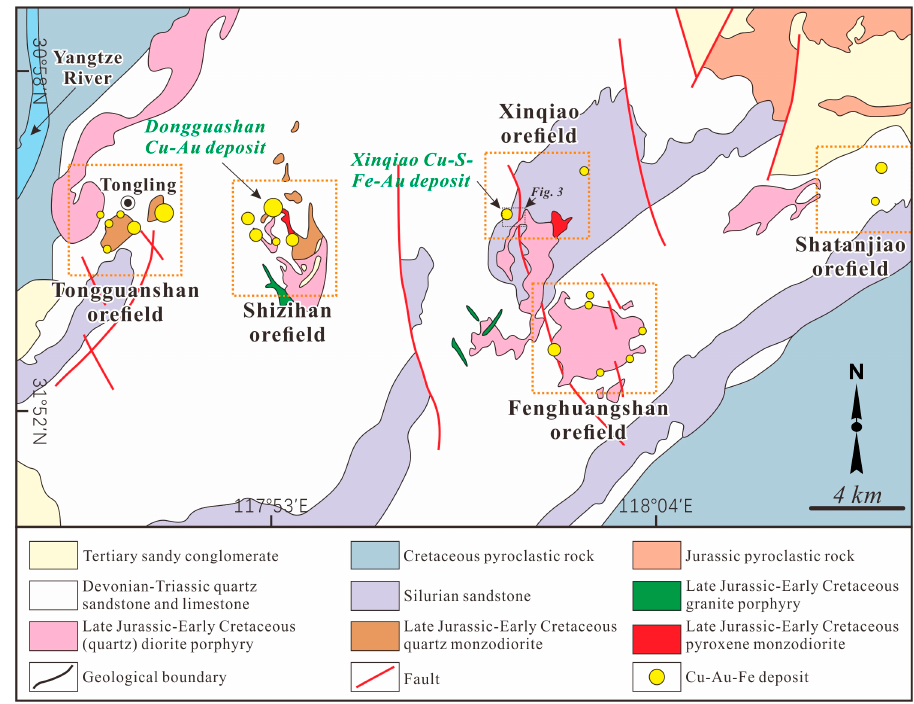
Figure 2. Geological map of the Tongling district (modified from [27]).